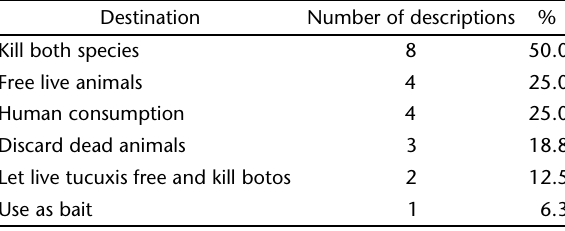
Table IV. Destination of entangled botos and